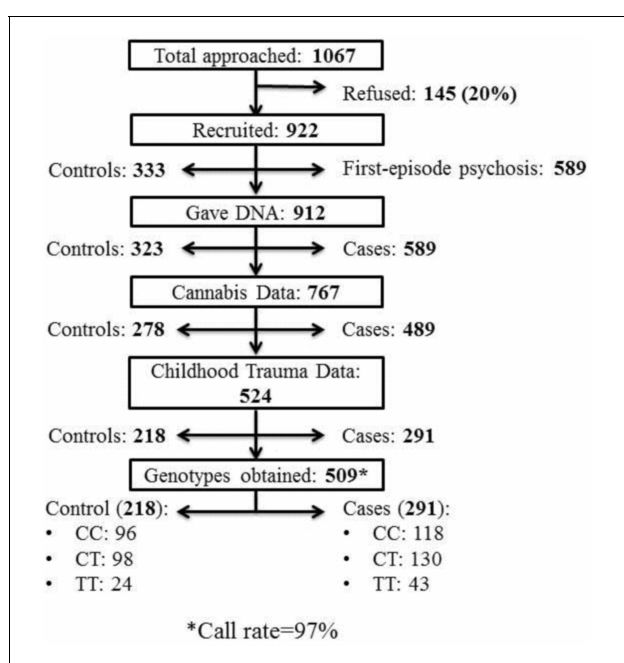
FIGURE 1 | Flow diagram and numerical breakdown of outcomes for subject recruitment and genotyping